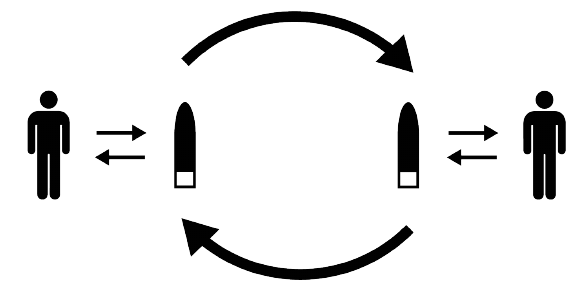
Figure 1: The figure shows how two human beings can be in rela- tion through the use of teledildos which capture and transfer their motions and tactile stimuli.